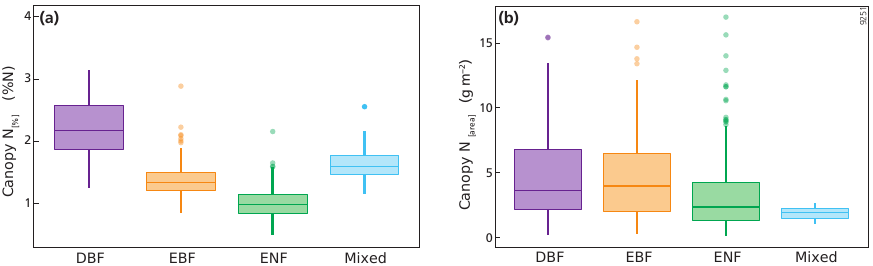
Figure 2. Box plots of (a) canopy nitrogen (N) concentration (canopy N [ % ] , %N) for deciduous broadleaf forest plots (DBF, n = 80), evergreen broadleaf forest plots (EBF, n = 186), evergreen needleleaf forest plots (ENF, n = 564) and mixed forest plots (mixed, n = 16); (b) canopy N content (canopy N [ area ] , gm − 2 ) for DBF plots ( n = 80), EBF plots ( n = 186), ENF plots ( n = 563) and mixed plots ( n = 12).